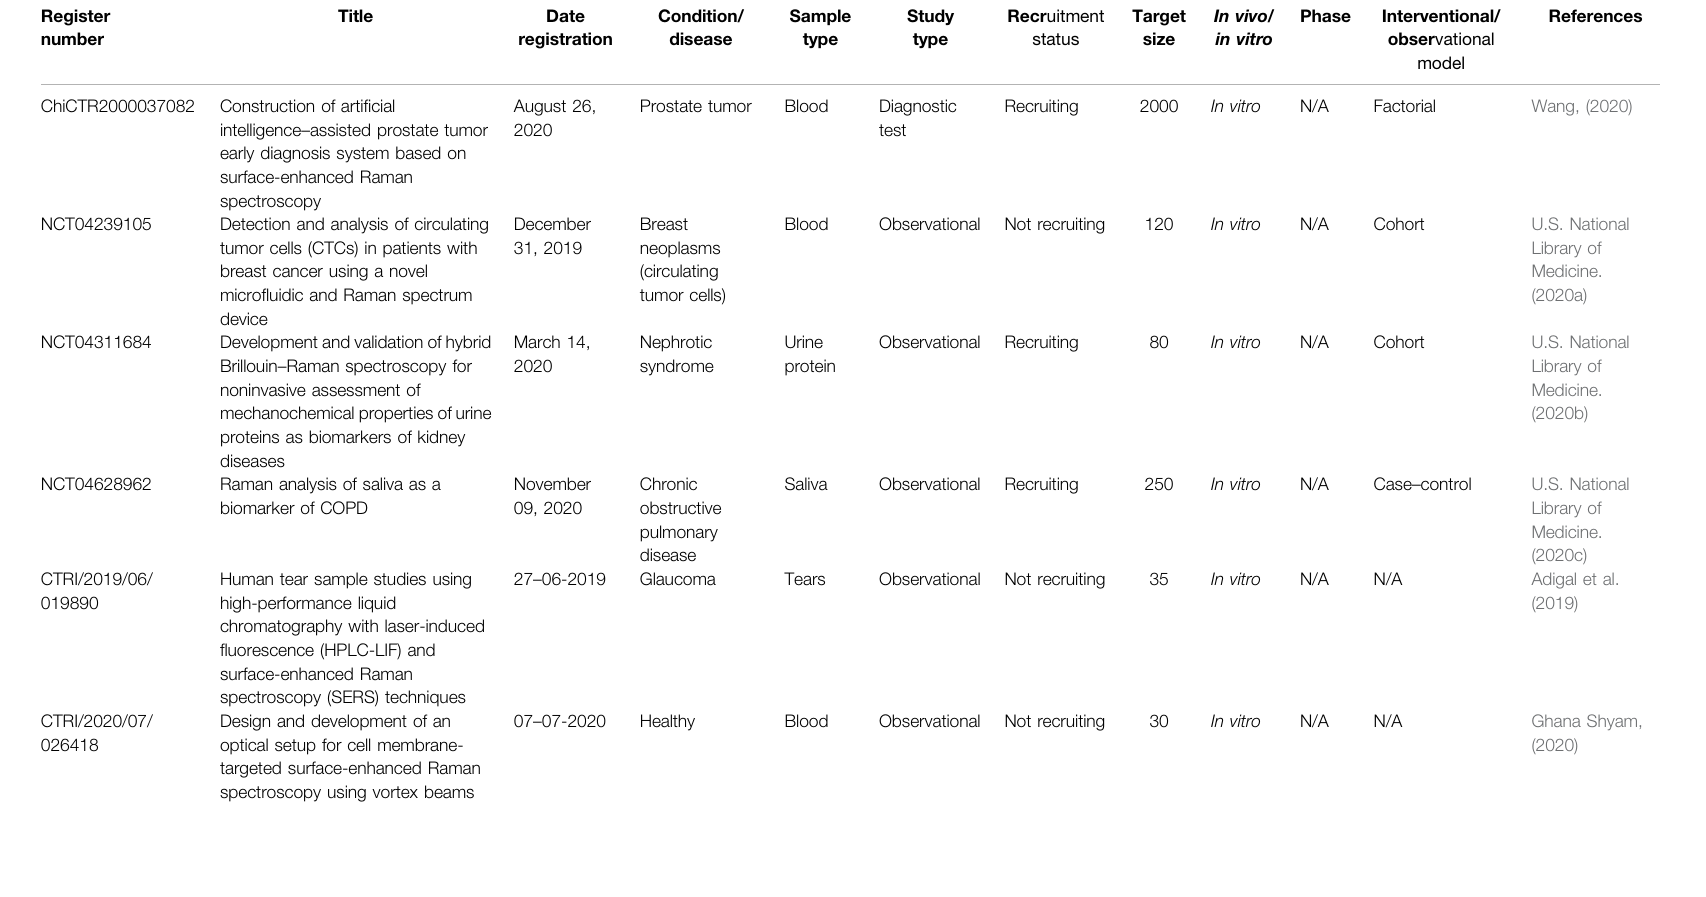
TABLE 3 | Characteristic of registered SERS clinical